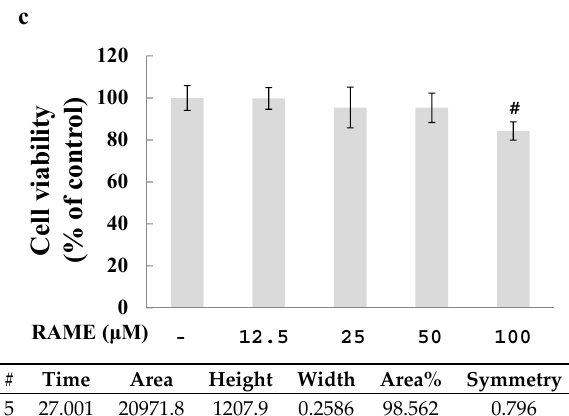
Figure 1. Chemical structure of RAME and its effects on cell viability. ( a ) Chemical structure of RAME; ( b ) Purity of RAME from a mutant cultivar of P. frutescens measured by HPLC analysis; ( c ) Cell viability. # p < 0.05 vs. control.